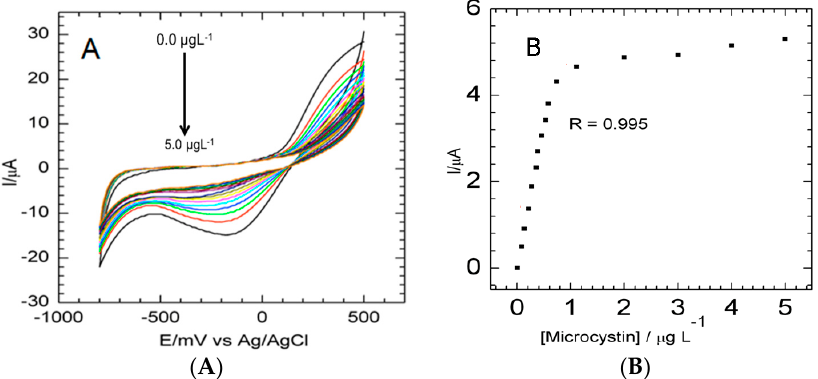
Figure 6. ( A ) Cyclic voltammograms of aptatoxisensor for detection of MC-LR; and ( B ) calibration curve showing GCE|SDD–Co(II)|AgNPs|MC-LRA responses to MC-LR.